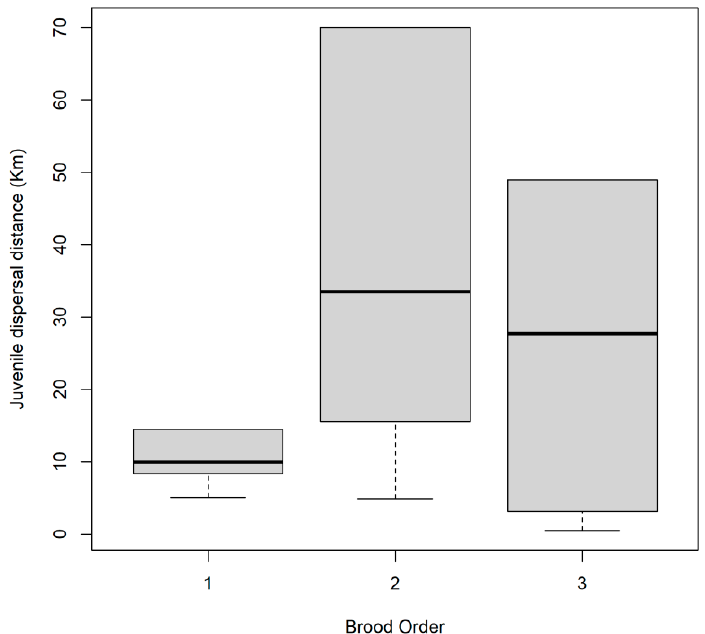
Figure 5. Boxplot for natal dispersal distance (km) according to brood rank order of Black-shouldered Kites ( Elanus caeruleus ) monitored in southwestern Spain. Horizontal lines = median and boxes are inter-quartile range. Sample size is nine, six and six first, second and third-order hatched nestlings within the brood, respectively.